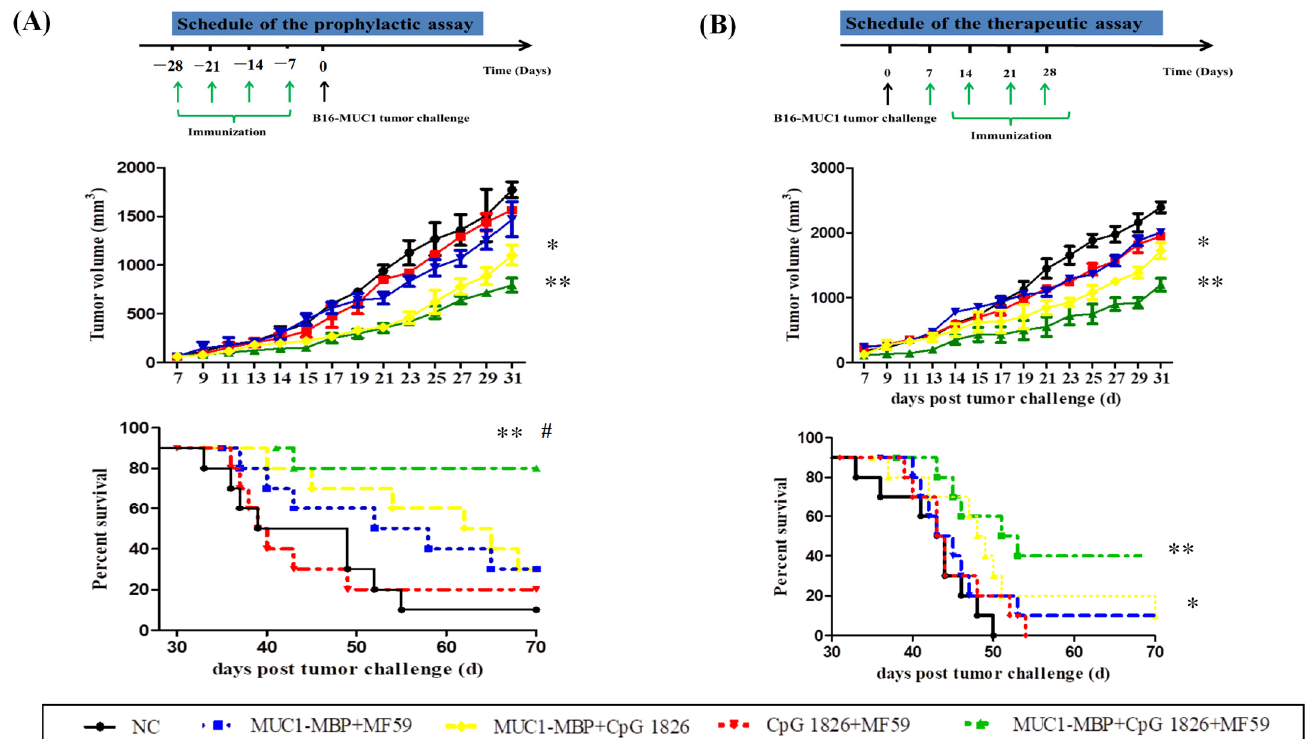
Figure 3. Antitumor effect of M-M combined with different adjuvants on survival in a prophylactic melanoma tumor model ( A ) and therapeutic model ( B ). ( A ) The immunization protocol in the prophylactic melanoma tumor Model. The tumor weight in each vaccine formulation ( n = 10). The survival in each vaccine formulation. ( B ) Antitumor effect of M-M combined with different adjuvants in a therapeutic melanoma tumor model. The immunization protocol in the therapeutic melanoma tumor Model. The tumor weight in each vaccine formulation ( n = 10). The survival in each vaccine formulation. * p < 0.05, ** p < 0.01 vs. NC group. # p < 0.05 vs. the M-M/CpG 1826 group.